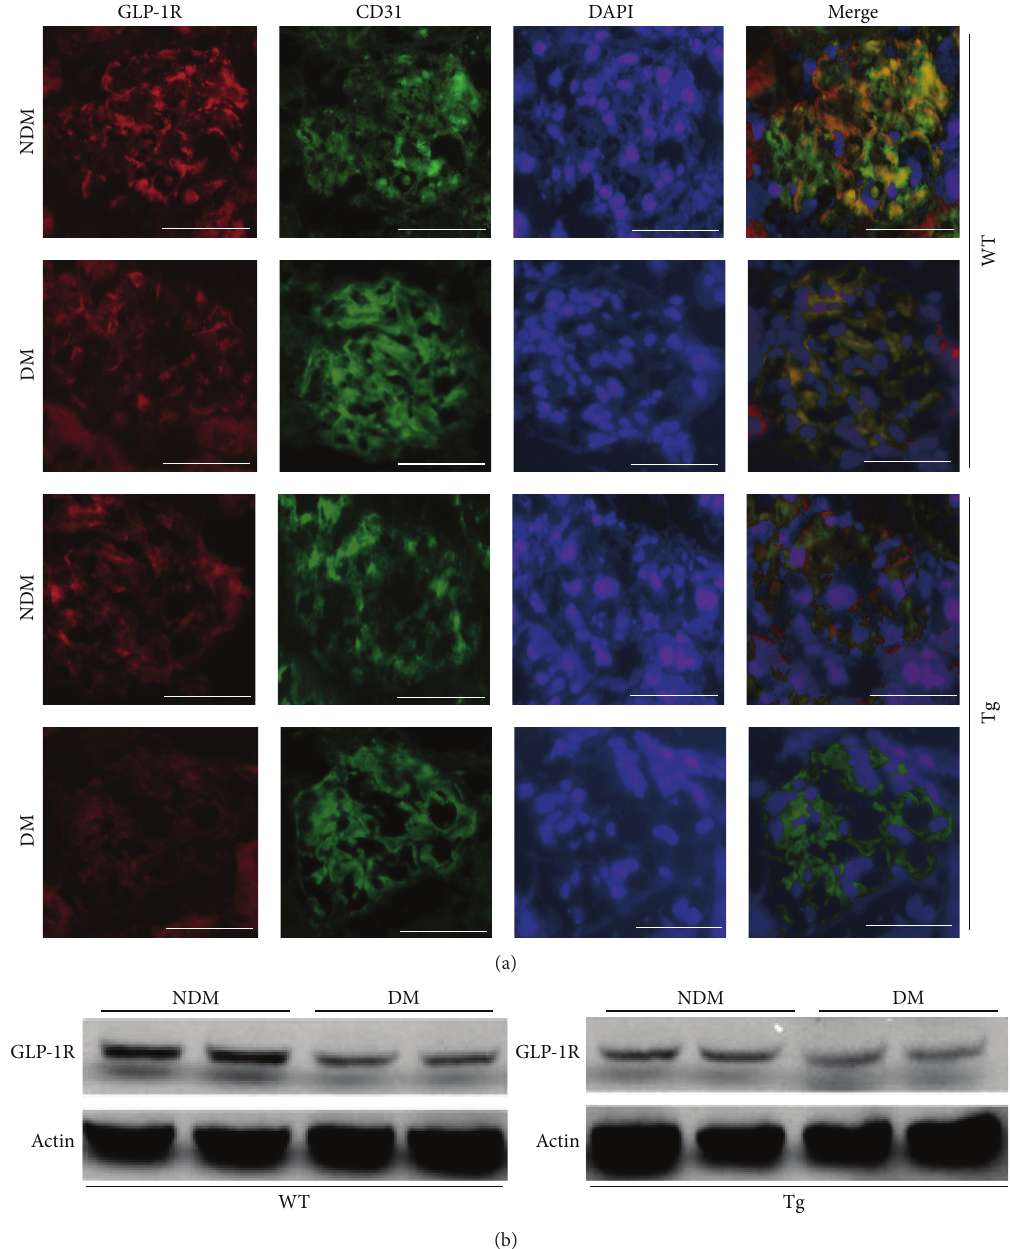
Figure 1: Overexpression of PKC 𝛽 2 in mouse glomerular endothelial cells (EC-PKC 𝛽 2Tg) and decreased glucagon-like peptide-1 receptors in diabetes. (a) Immunostaining of GLP-1R and CD31, showing merged images of the glomeruli. (b) Immunoblots of GLP-1R from renal cortex of mice. Images are reproduced from Mima et al. [11], with permission from Diabetes